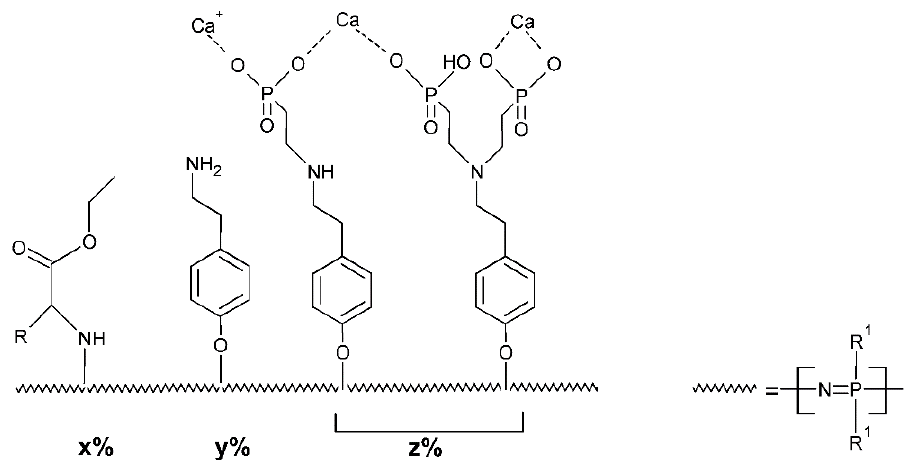
Figure 19. Polyphosphazene–calcium phosphate composites.